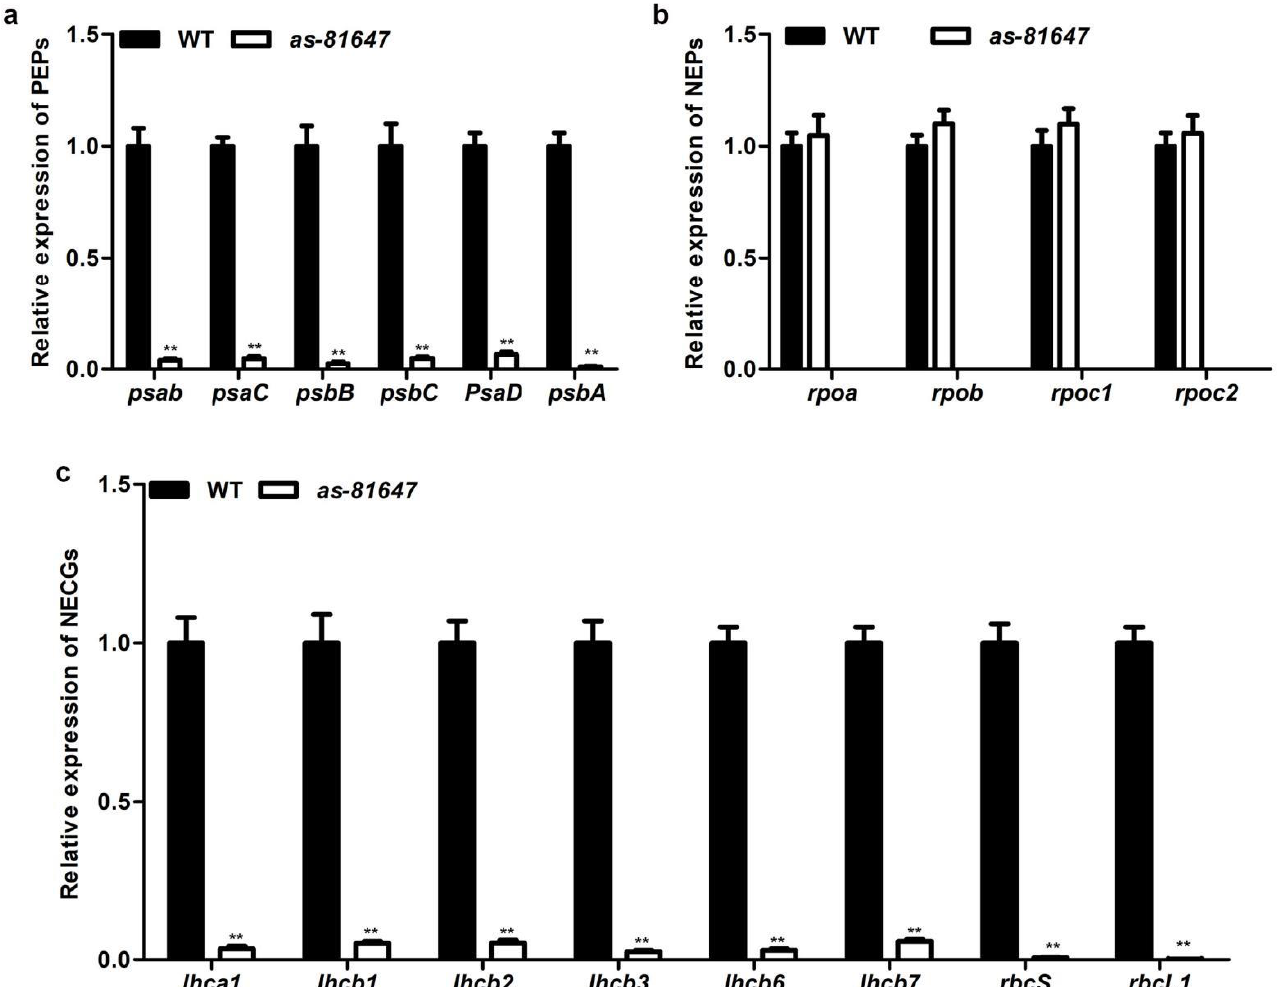
Figure 5. Relative expression levels of genes involved in chlorophyll biosynthesis and development. ( a ) qRT-PCR analysis of PEP-dependent photosynthesis genes (PEPs). ( b ) qRT-PCR analysis of NEP-dependent genes (NEPs). ( c ) RT-PCR analysis of photosynthesis-associated genes encoded by the nucleus (NECGs). Values and bars represent the mean and standard obtained from three biological replicates, respectively. RNA levels were normalized by the ZmActin gene ( Zm00001d010159 ). ** P < 0.01 (Student’s t-test).